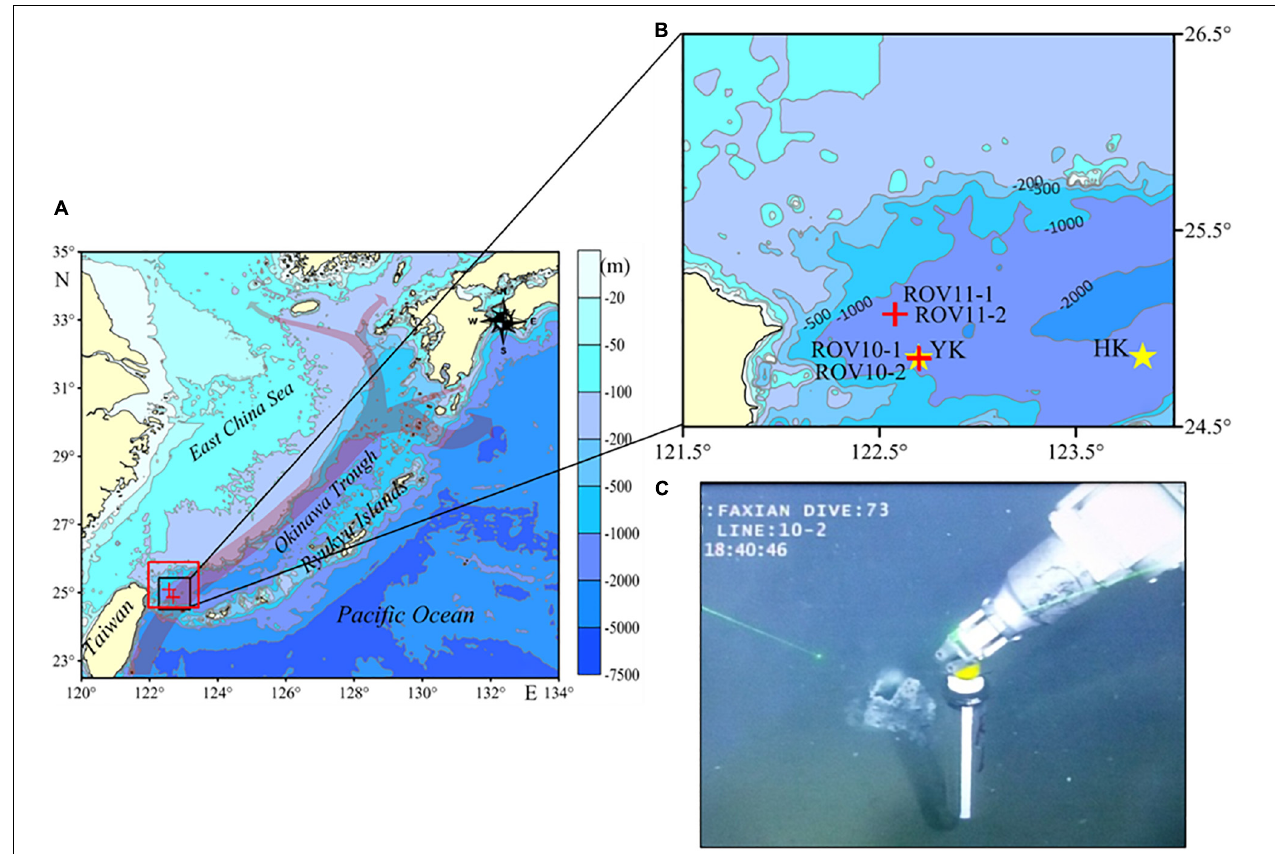
FIGURE 1 | (A) Locations of the sampling sites in the southern Okinawa Trough: gray arrows indicates the flow path of the Kuroshio Current (redrawn from Kao et al., 2006), the red rectangle indicates the location of SPOT (adapted from Glasby and Notsu, 2003). (B) Expanded view of the sampling locations: red crosses indicate the sampling locations, and yellow stars indicate the locations of Yonaguni Knoll (YK) and Hatoma Knoll (HK). (C) Picture of core ROV10-1 being collected by the robotic arm of the